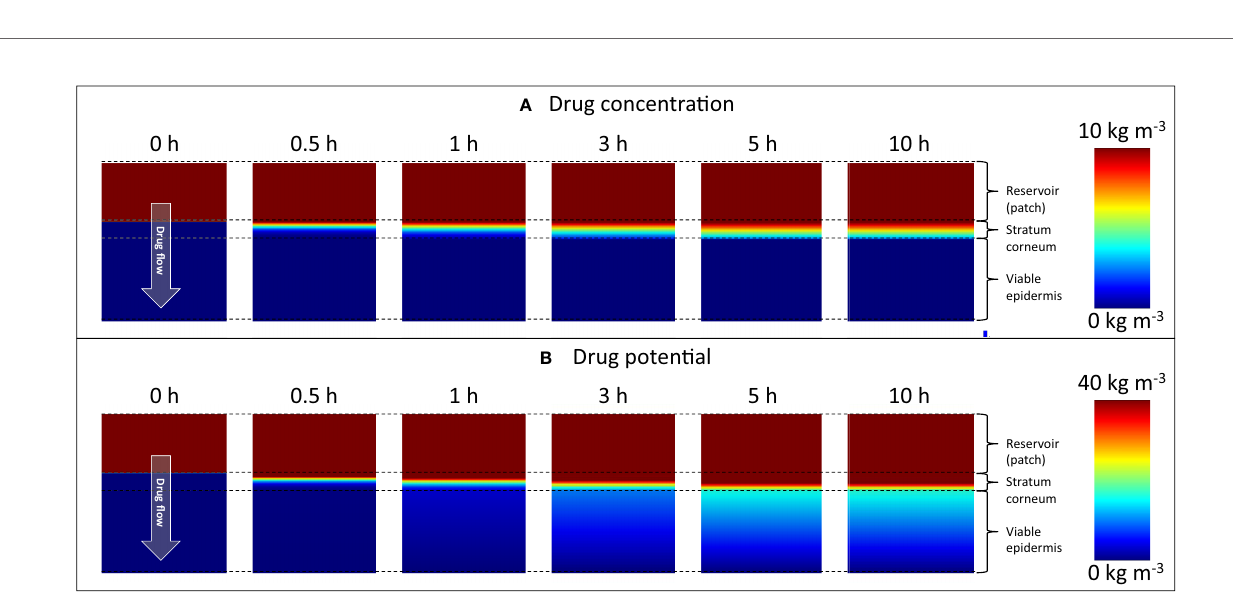
FIGURE 9 | Color contours of (A) drug concentration (c i a ) and (B) drug potential ( y a ) in the drug reservoir and epidermis for different points in time. Different scaling is used in (A, B) to improve clarity. Note that the maximal range (80 kg m -3 ) is not depicted.